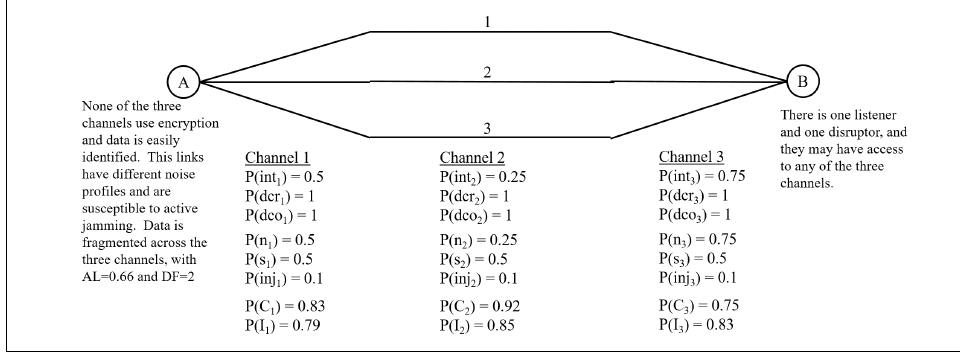
Figure 6. A Three-Channel, Point-to-Point Network with QoSS Characteristics.